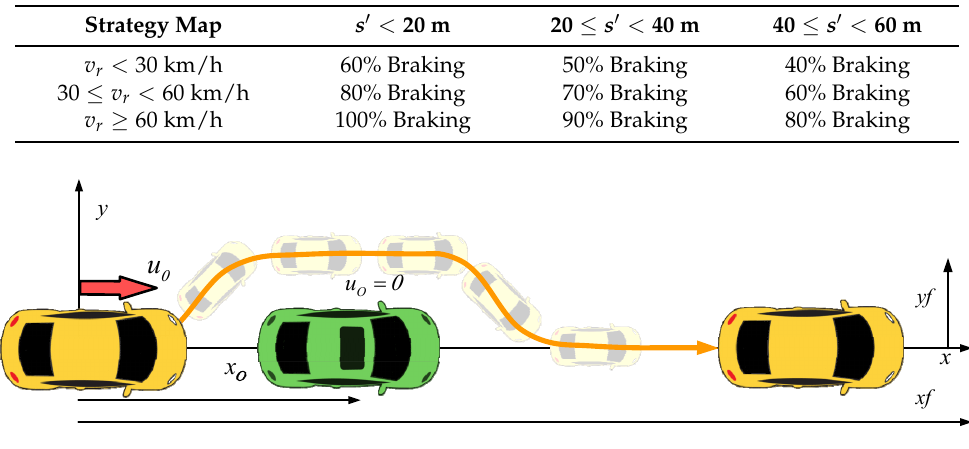
Figure 3. Schematic of the vehicle changing lanes to avoid collision.